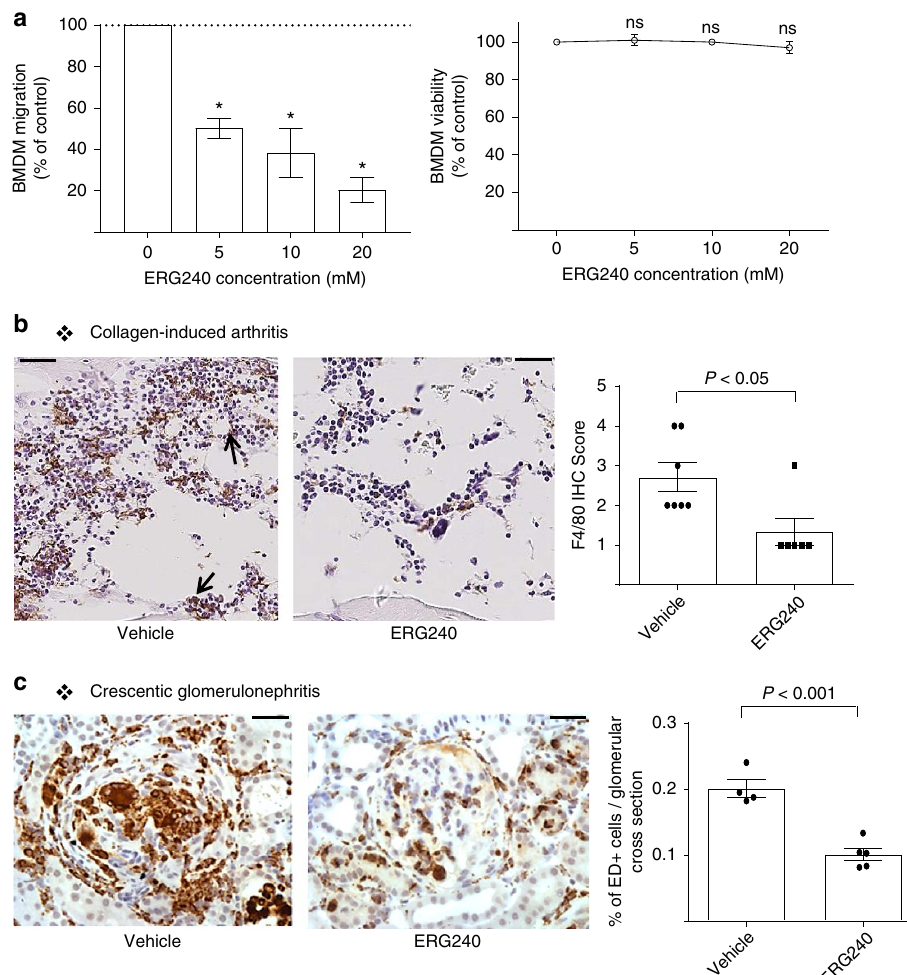
Figure 6 | ERG240 treatment results in reduced macrophage infiltration in CIA and crescentic glomerulonephritis. ( a ) Inhibition of murine BMDM migration in vitro in the presence of different concentrations of ERG240 by transwell migration assay (left panel, results are presented as the average of four experiments). The drug had no effect on cell viability (right panel, results are presented as the average of three experiments). ( b ) IHC analysis of CIA joints for expression of F4/80. Representative images show F4/80 þ cells (indicated with an arrow). F4/80 þ cell quantification is shown on the right panel. ( c ) Representative images showing glomerular ED1 (rat CD68)-positive cells in ERG240 treated animals following NTN. Percentage of glomerular ED1-positive cell quantification is shown on the right panel. Error bars are s.e.m. Either one-way ANOVA or Student’s t -test were used for significance. * P o 0.001; ns, non-significant when compared with 0mM ERG240 by one-way ANOVA. Scale bars, 50 m m (collagen-induced arthritis); 20 m m (crescentic